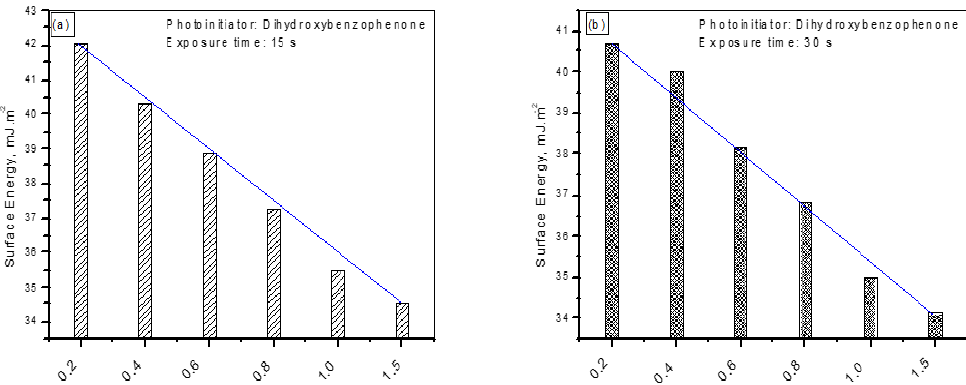
Figure 11. Surface energy as a function of photoinitiator concentration at ( a ) 15 s exposure time and ( b ) 30 s exposure time.